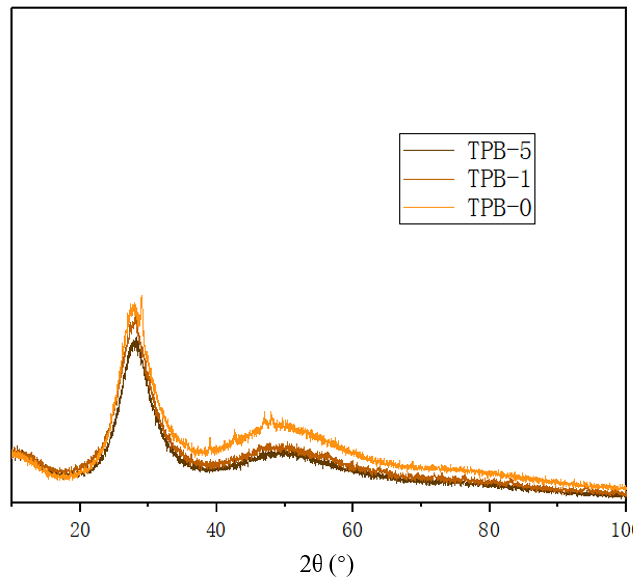
Figure 2. X-ray diffraction (XRD) pattern of TPB series glass.